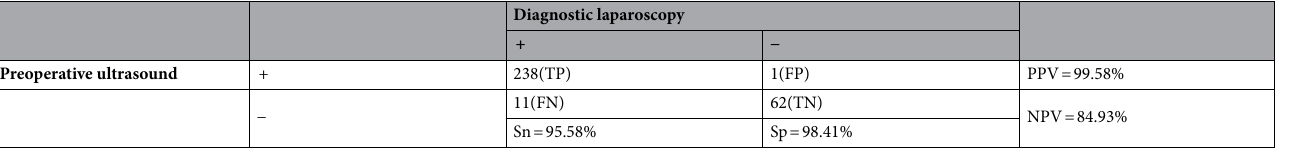
Table 1. The comparison list of NPT by preoperative ultrasound and diagnostic laparoscopy. TP true positive, FP false positive, PPV positive predictive value, NPV negative predictive value, FN false negative, Sn sensitivity, Sp